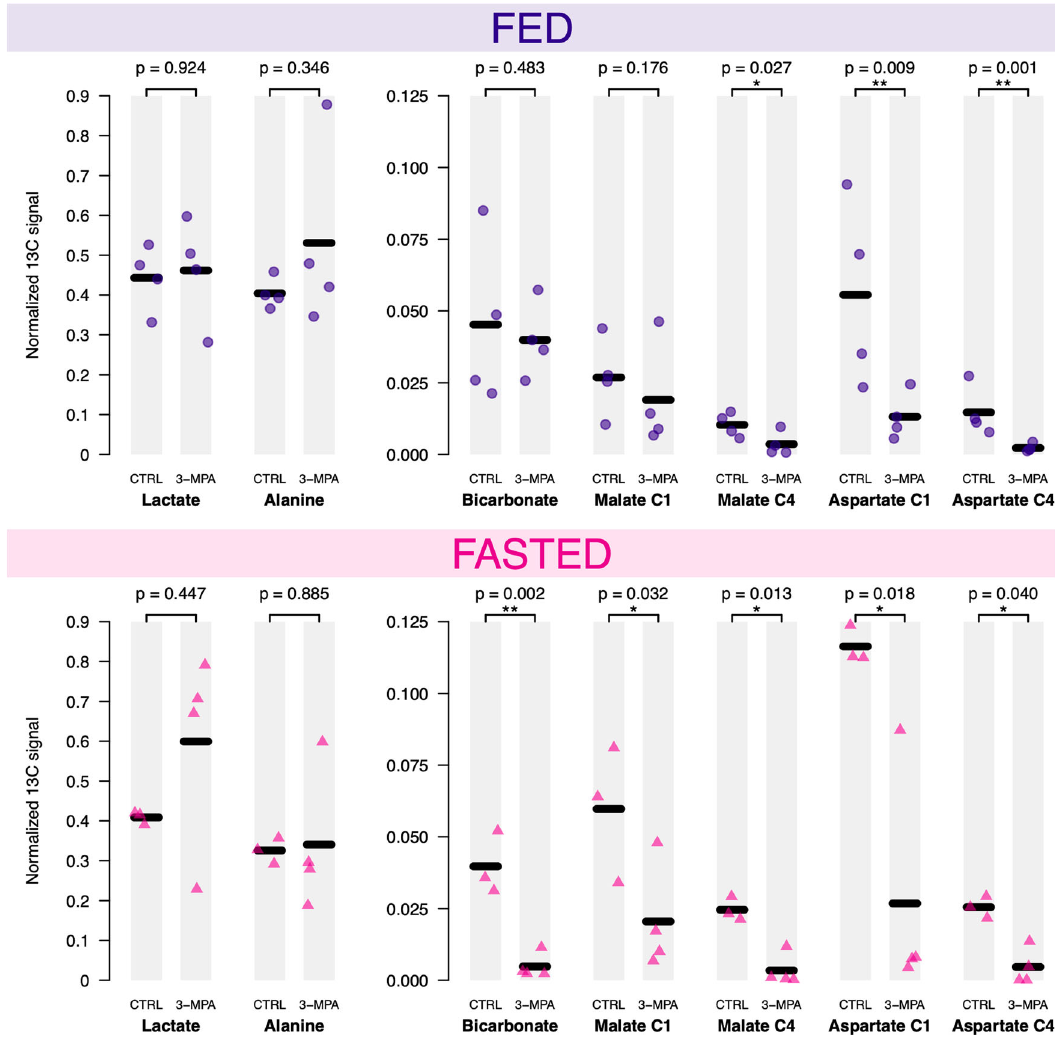
Fig. 4 13 C-metabolites signal intensities in control and PEPCK-inhibited rats in two different nutritional state. Comparison of the HP [1- 13 C]lactate, HP [1- 13 C]alanine, HP [ 13 C]bicarbonate, HP [1- 13 C]malate, HP [4- 13 C]malate, HP [1- 13 C]aspartate, and HP [4- 13 C]aspartate signal intensities normalized to the total sum of metabolites measured following the injection of HP [1- 13 C]pyruvate in control and PEPCK-inhibited (3-MPA treated) rats in the fed (upper plot) and fasted (lower plot) state. P -values were determined by Student ’ s t tests on the log scale. One-sided tests were performed when analyzing bicarbonate, malate and aspartate outcomes. Two-sided tests were used when analyzing lactate and alanine data. Normalized HP [ 13 C]bicarbonate signal intensities show a signi fi cant difference between the control and 3-MPA treated groups only in the fasted